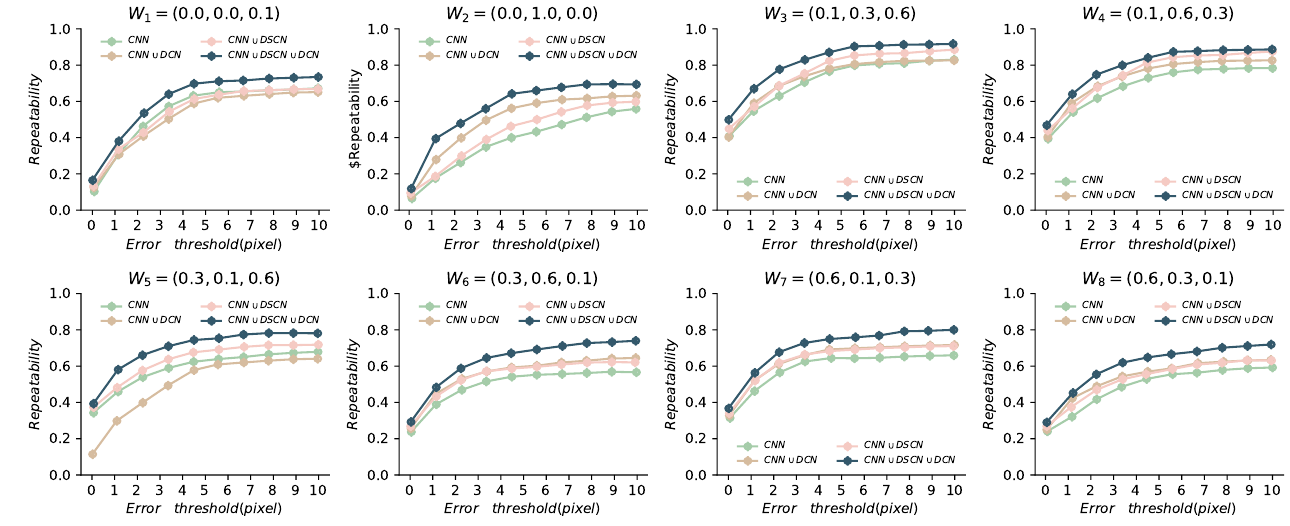
Figure 6. Comparison between network combinations and scale weight parameters with different pixel error